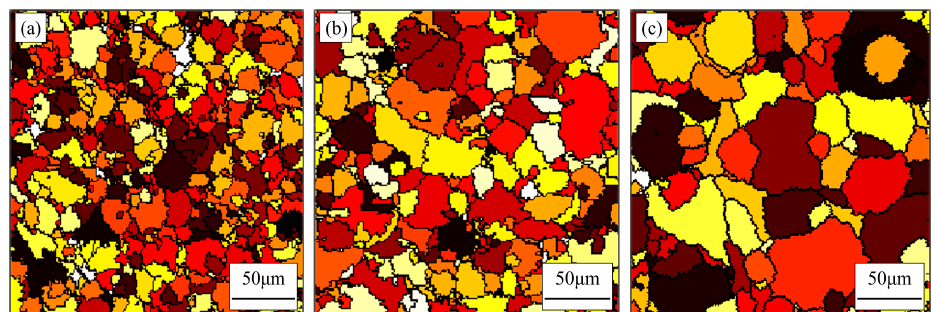
Figure 6. Optical Microstructures of FeMnSiCrNi SMA undergoing compression ( T = 850 ◦ C, ε = 0.9): . ε = ( a ) 0.5 s − 1 ; ( b ) 0.05 s − 1 ; ( c ) 0.005 s − 1 .